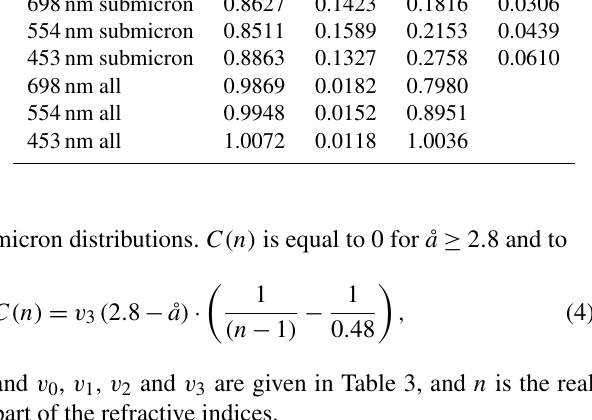
Table 3. Coefficient values for v 0 , v 1 , v 2 , and v 3 for Eqs. (3) and (4) (Massoli et al., 2009). v 0